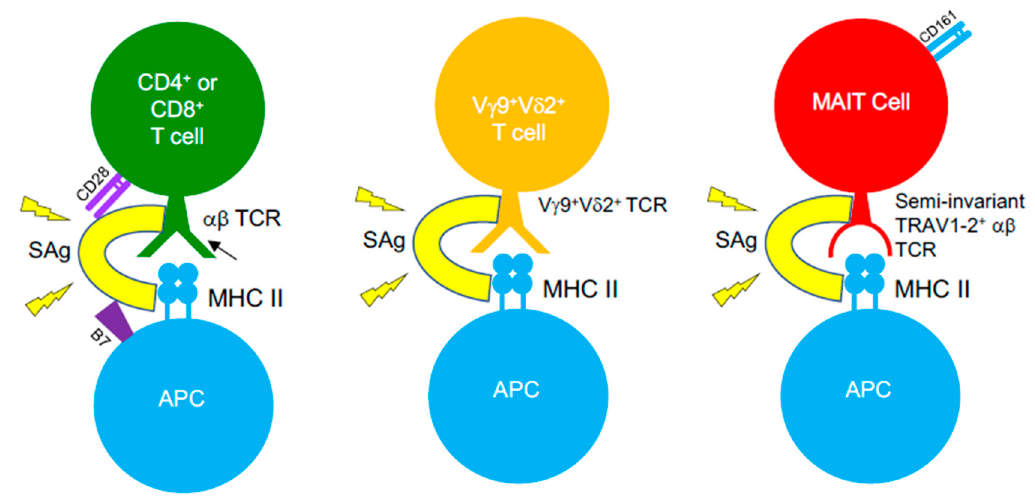
Figure 3. SAgs target αβ and γδ TCRs on different T cell subsets. SAgs bypass conventional TCR–